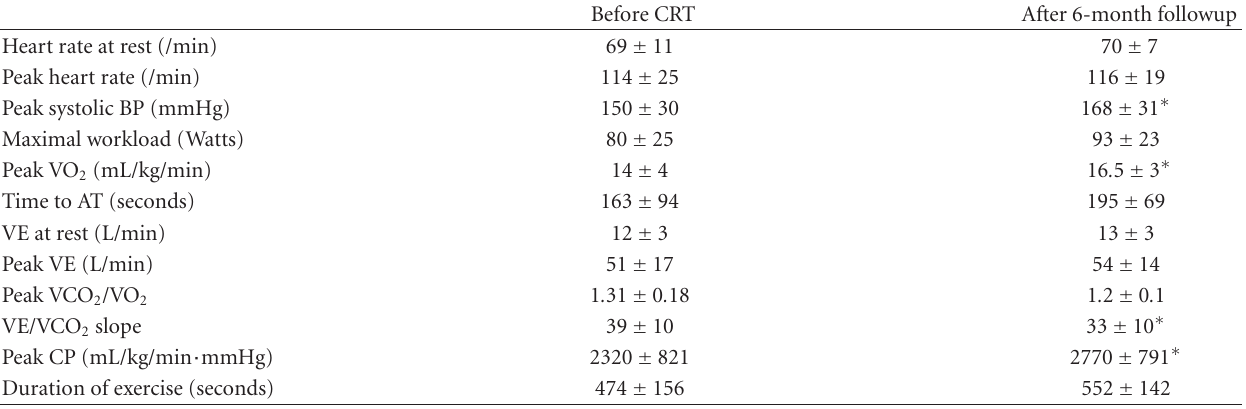
Table 3: Comparison of exercise data before and after CRT. Values are given as means ± SEM. AT, anaerobic threshold; BP, blood pressure; CP, circulatory power. ∗ P < 0 . 05 compared with